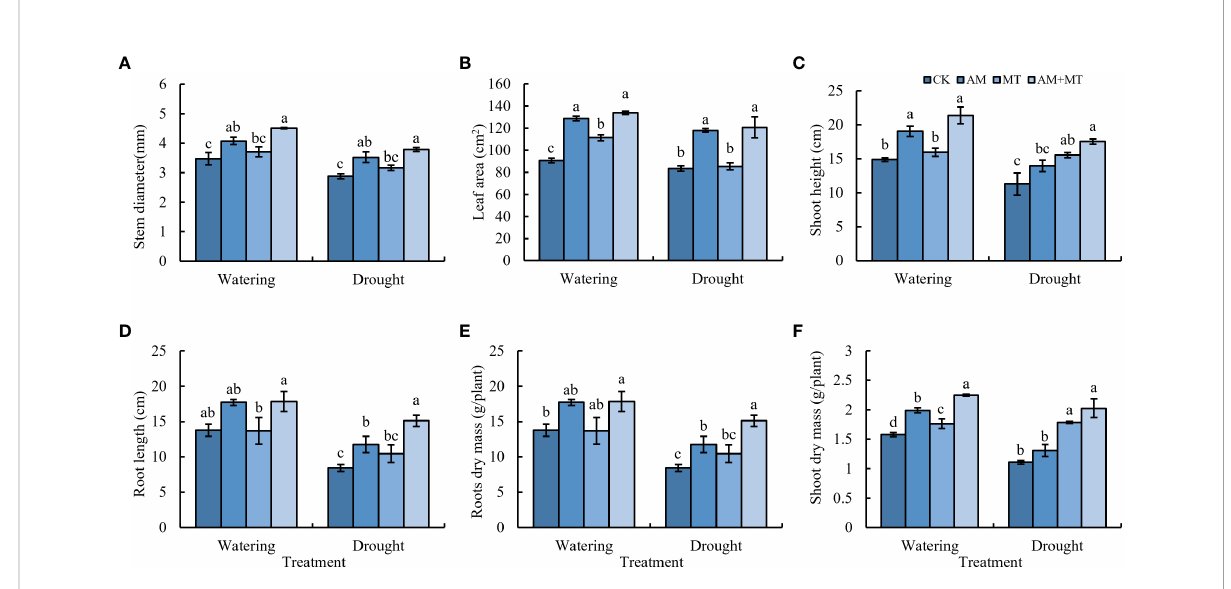
FIGURE 3 Effect of treatments on plant growth, including stem diameter (A) , leaf area (B) , shoot length (C) , root length (D) , root dry mass (E) , shoot dry mass (F) . Data are presented as meant ± SD ( n = 6), different letters indicate signi fi cant differences between treatments at p < 0.05 by Tukey ’ s Post Hoc test. Treatments included CK (the control), AM (inoculated with arbuscular mycorrhiza), MT (irrigated with 100 m M melatonin), and AM +MT (treated with melatonin and arbuscular